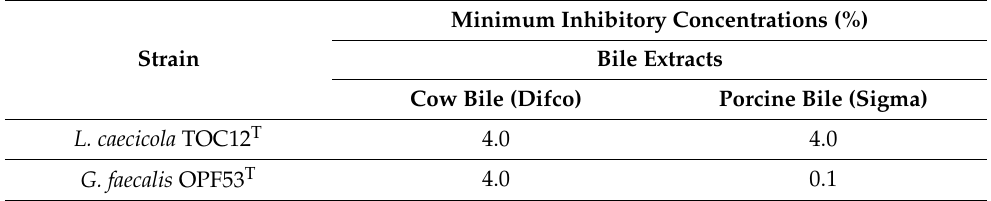
Table 1. Minimum inhibitory concentrations of bile extracts against strains TOC12 T and OPF53 T .